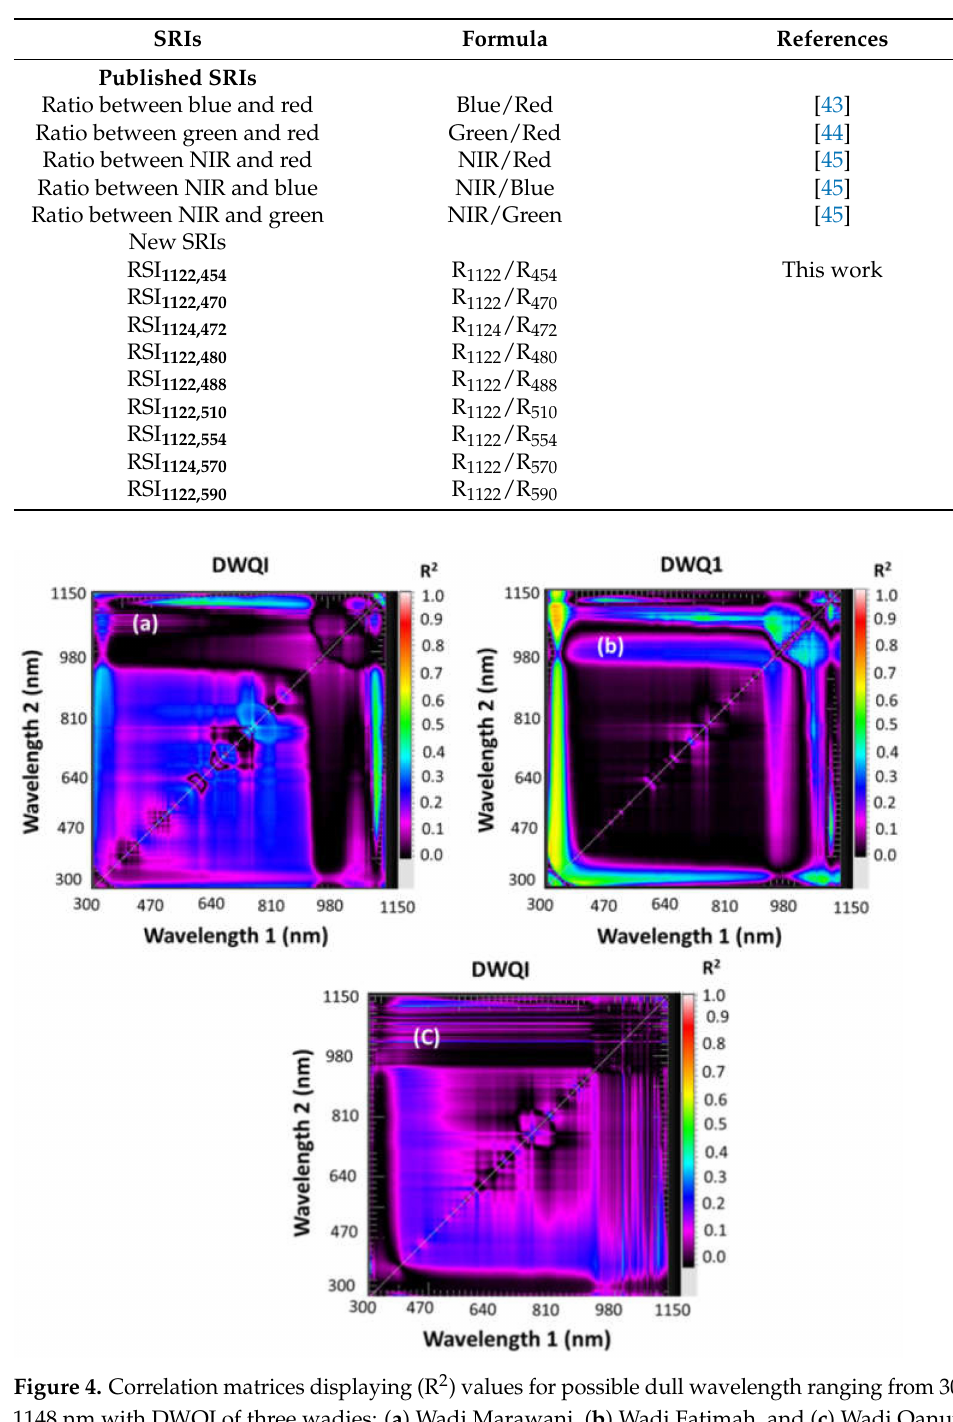
Table 1. Description of different SRIs used in this work.